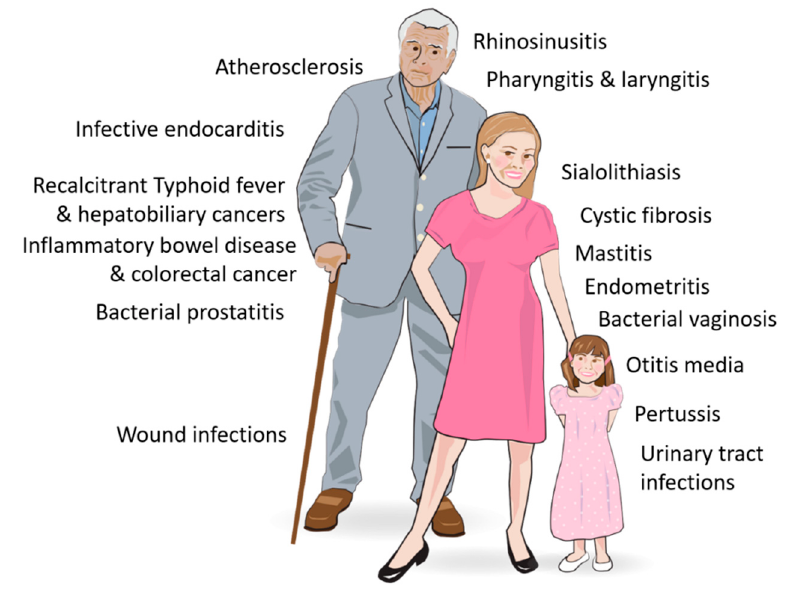
Figure 6. Diseases associated with bacterial biofilms.